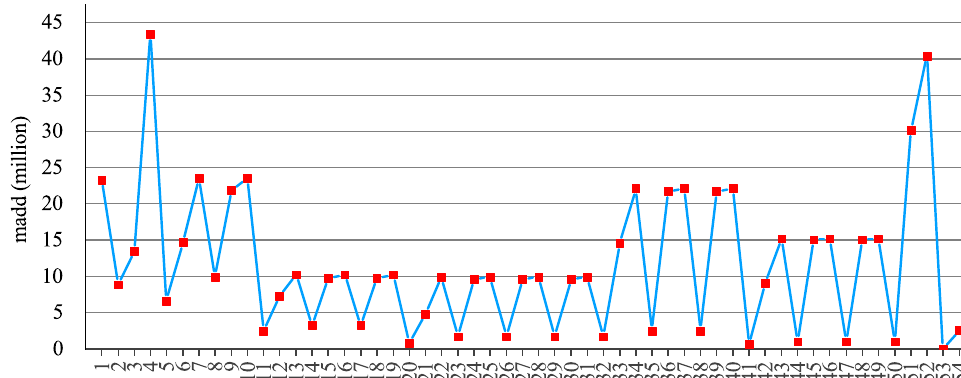
Figure 12. Total multiplication and addition of each layer.